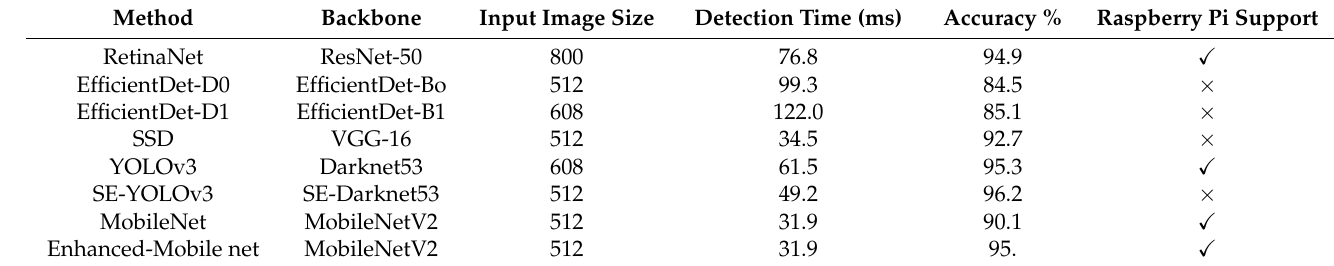
Table 4. Real-time face mask detection model comparative study.